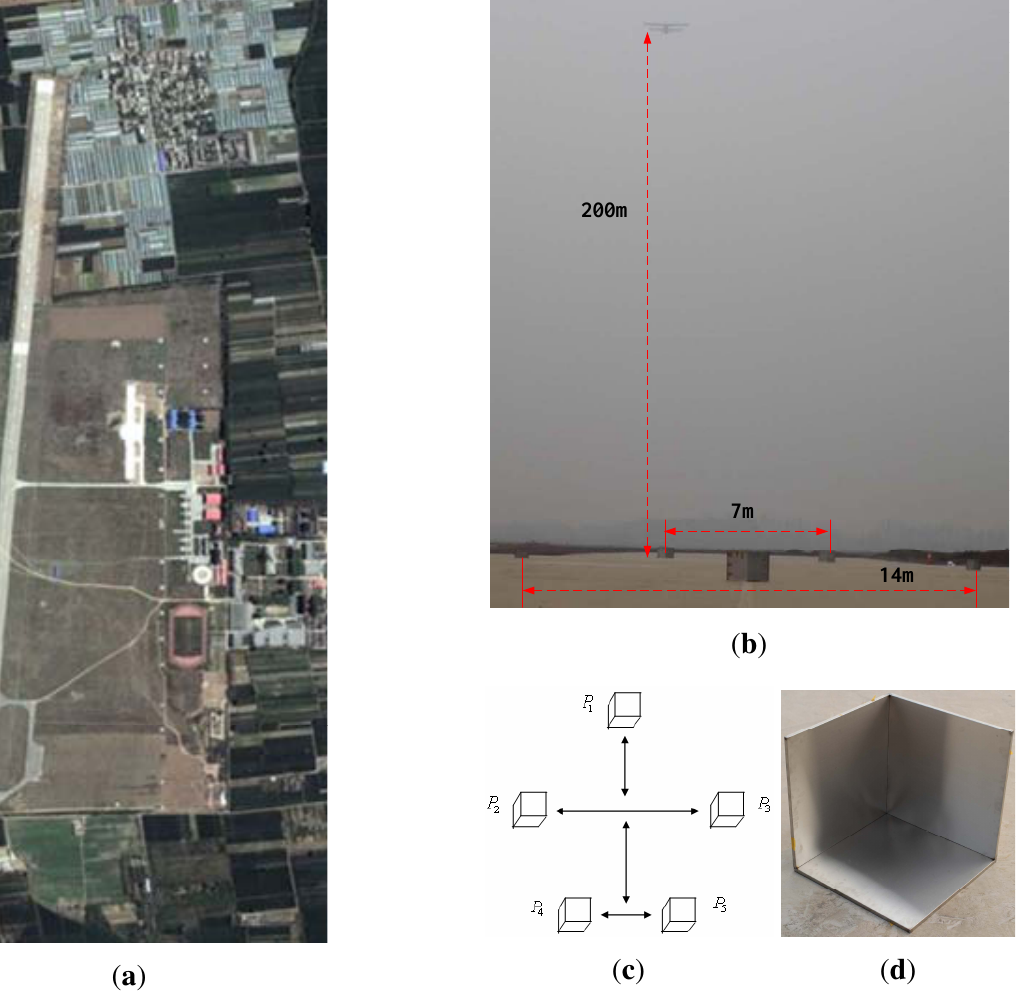
Figure 9. ( a ) Optical image of imaging scene; ( b ) Radar platform and five corner reflectors in the scene; ( c ) The schematic plot of the distribution of trihedral reflector; ( d ) Enlargement of trihedral reflector.